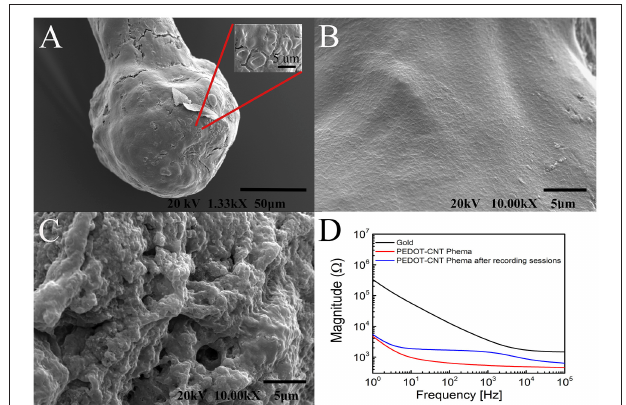
FIGURE 5 | Representative SEM images of (A) a pHEMA encapsulated PEDOT-PSS-CNT microsphere after recordings in rat and (B) the higher magnification of the pHEMA surface after recordings in rat. (C) Magnification of the surface of a PEDOT-PSS-CNT coated microsphere (without pHEMA) after recordings in rat. (D) Example of magnitude impedance of a pHEMA encapsulated PEDOT-PSS-CNT coated microsphere before and after various recording